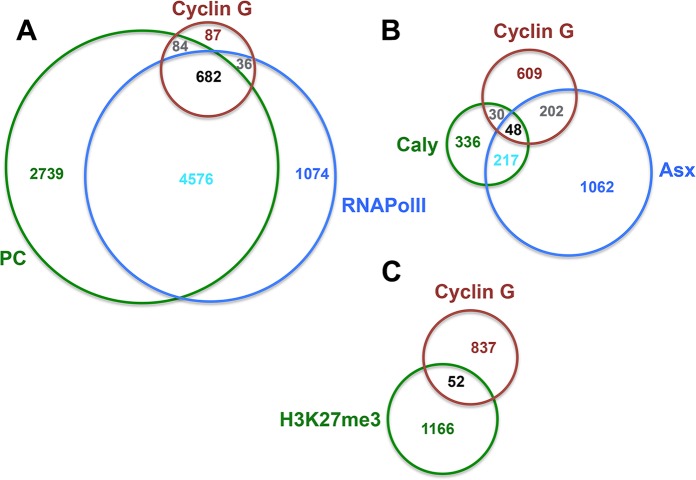
Cyclin G shares target genes with PRC1, Asx and RNAPolII but not with
Calypso.Venn diagrams showing the intersection between Cyclin G-bound genes in
+/ UAS-CycGΔP;
da-Gal4/+ wing imaginal discs with Pc and RNAPlII (A), Asx
and Calypso (B), and K3K27me3 (C) in wild-type wing imaginal discs.